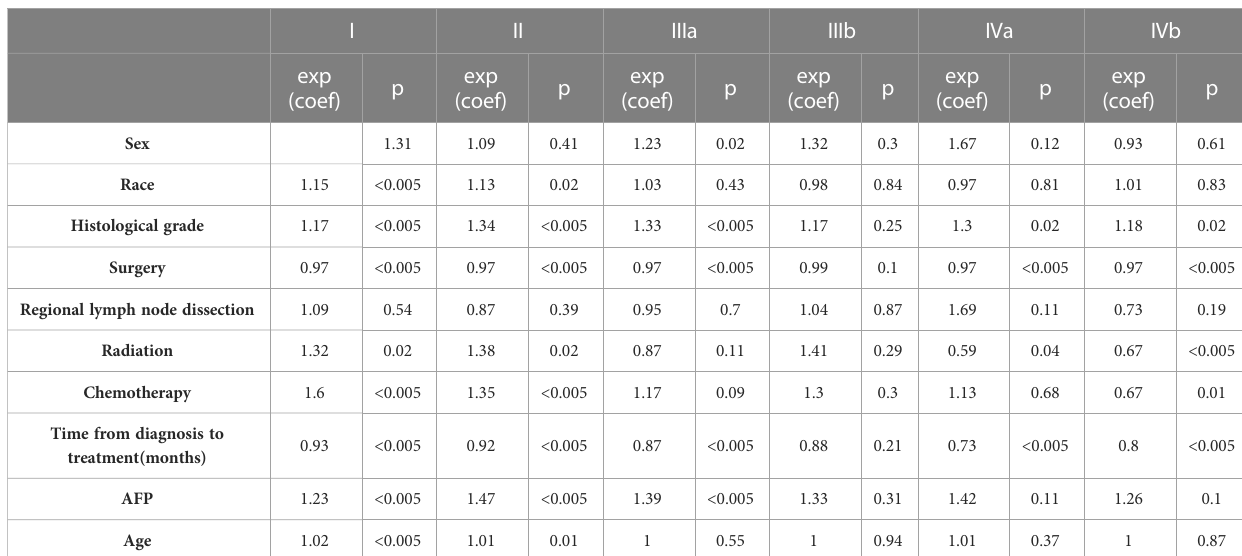
TABLE 3 Risk factors at different stages.